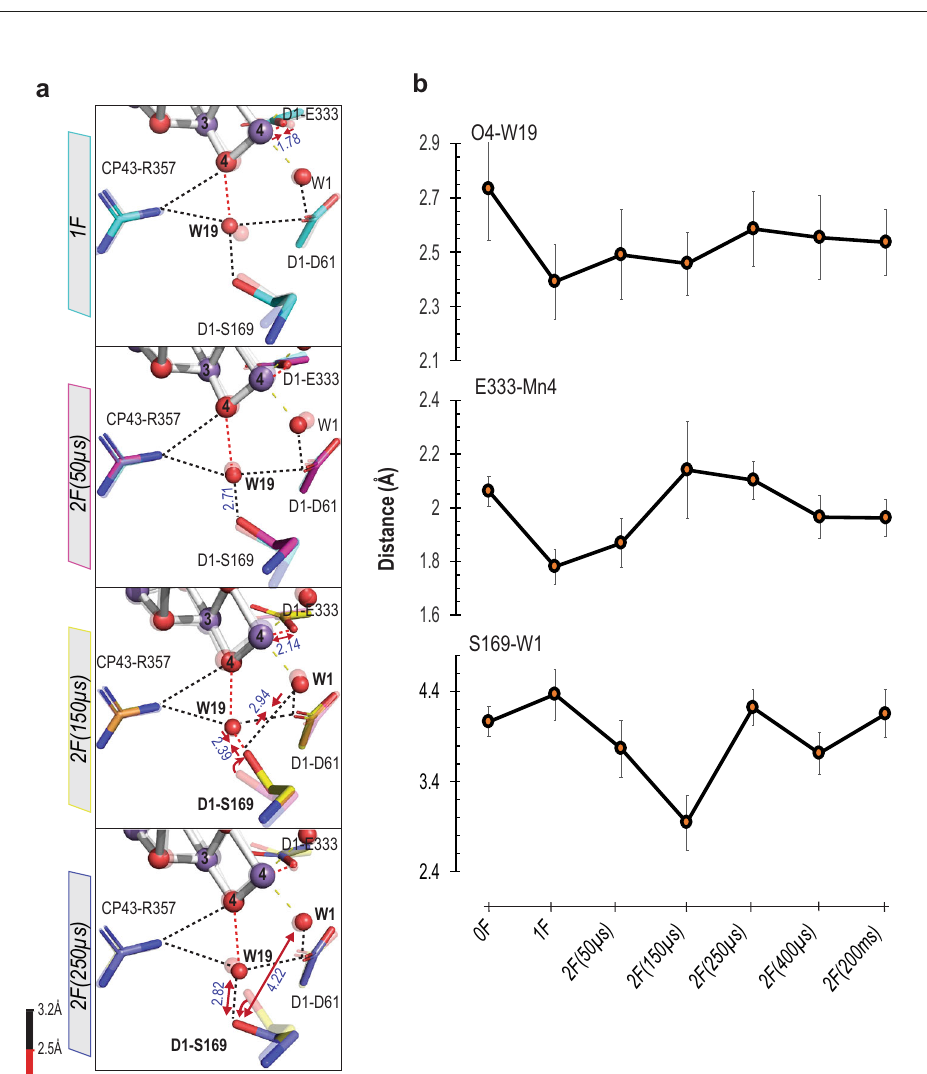
Fig. 3 Structural changes in the O1 channel during the S 2 → S 3 transition. a The structural changes in the O1 channel are shown for all time points in the S 2 → S 3 transition (1F (teal, PDB: 7RF3) and 2F time points (50 µ s: magenta, PDB: 7RF4; 150 µ s: yellow, PDB: 7RF5; 250 µ s: slate, PDB: 7RF6; 400 µ s: orange, PDB: 7RF7; 200 ms: green, PDB: 7RF8)). O1 channel is in red. Waters that show signi fi cant movement during the S 2 → S 3 transition are marked with a black dashed circle. ( B ): Structural changes at the beginning of the O1 channel during the transition at different time points: (1F (teal) and 2F time points (50 µ s: magenta; 150 µ s: yellow; 250 µ s: slate)). Each model overlaid with the model of the earlier time point, shown in a transparent color. The waters are colored based on their occupancies, represented by a color gradient from white to red as shown at the bottom left. The positions for certain waters are con fi rmed by Fo-Fc omit maps contoured at different σ levels (3.5 σ , 4 σ ) with the exception of W30 at 1F and Ox omit maps contoured at 2 σ and 3 σ , respectively. The H-bond length is color-coded, as described at the bottom left. Movements of W26, W27, W39, and D1-E189 are marked with black dashed arrows. c Difference density heights from the Fo-Fc omit maps for selected waters in the O1 channel and Cl1 channel. Source data are provided as a Source Data fi le.